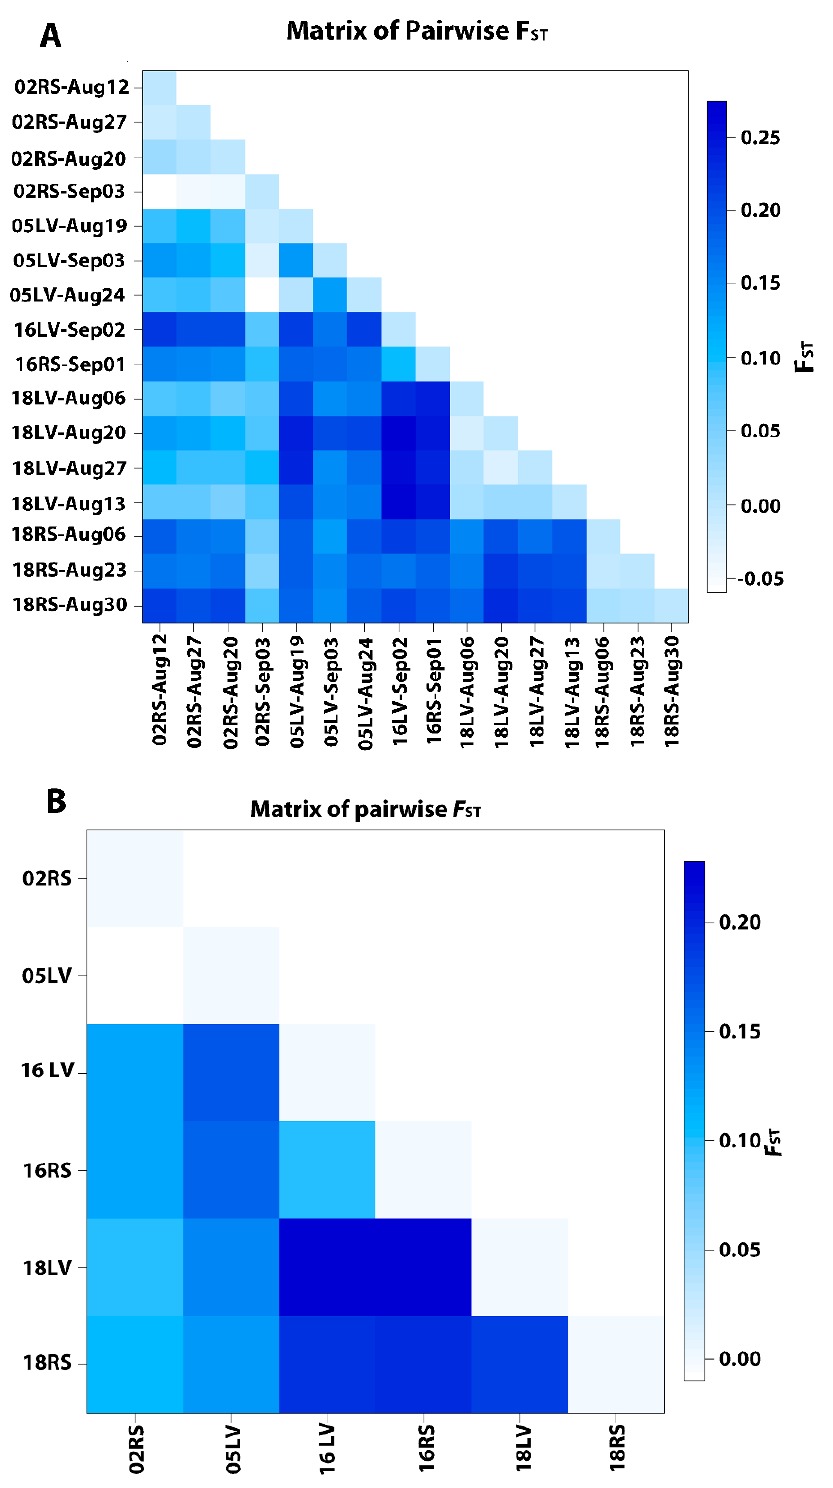
Figure 2. Matrix of pairwise F ST estimates for Helicoverpa zea collected from Landisville (LV) and Rock Springs (RS), PA, partitioned into 16 putative populations by collection date ( A ) and pooled into six populations by collection year ( B ). Putative population names use the convention of two-digit collection year (02, 05, 16 or 18), two letter collection site code, followed by collection month and date. Intensity of blue color squares corresponds to the F ST values shown in the scale bar. Corresponding data are provided in Supplementary Data Tables S9a,b.